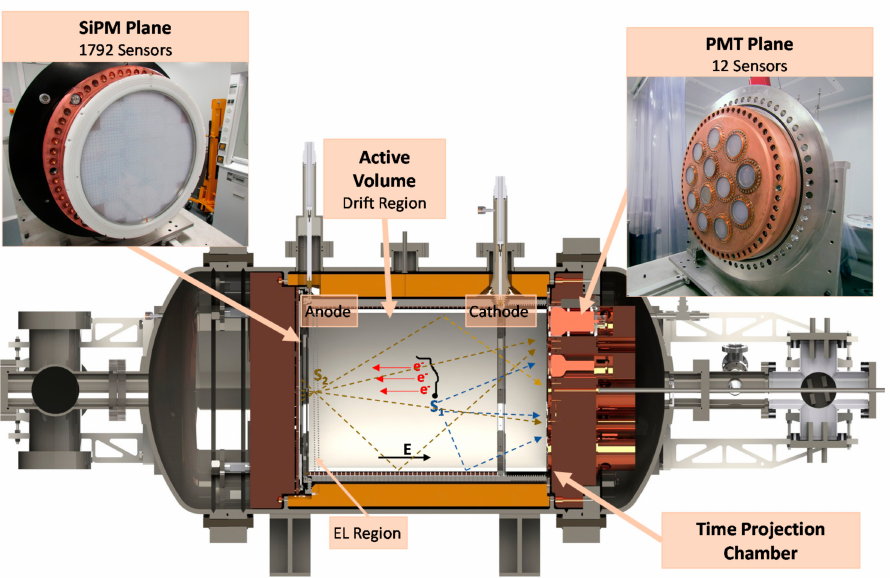
Figure 1. Schematic view of the NEXT-White Detector. Top right: Picture of the PMT sensors plane. Top left: Picture of the SiPM sensors plane. In the active volume of the TPC: Drawing with the principle of operation of the